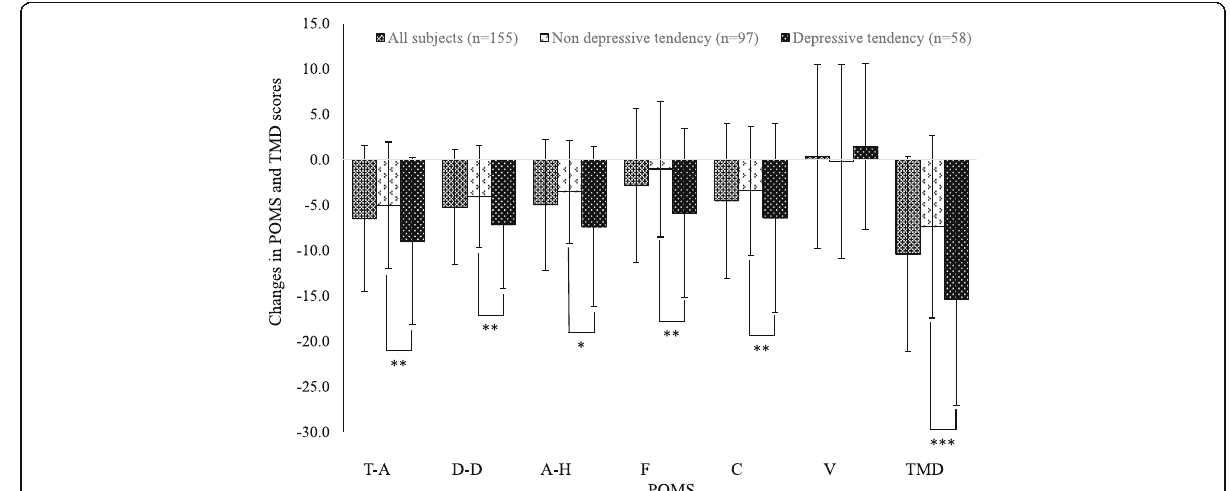
Fig. 2 Changes in POMS and TMD scores by forest bathing (after-before value). T-A Tension-Anxiety, D-D Depression-Dejection, A-H Anger- Hostility, F Fatigue, C Confusion, V Vigor, TMD Total Mood Disturbance. * p < 0.05, ** p < 0.01, *** p < 0.001, paired